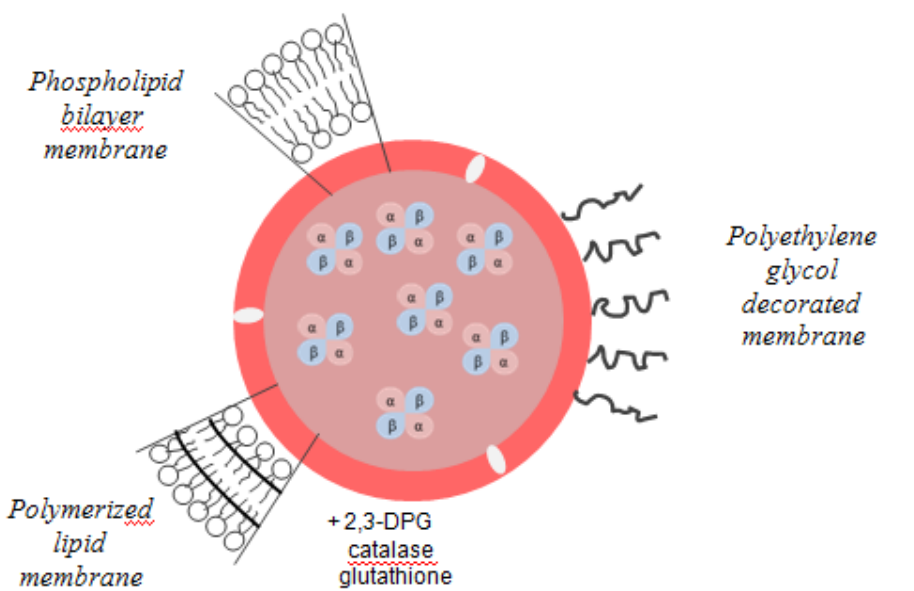
Figure 6. Liposome-encapsulated